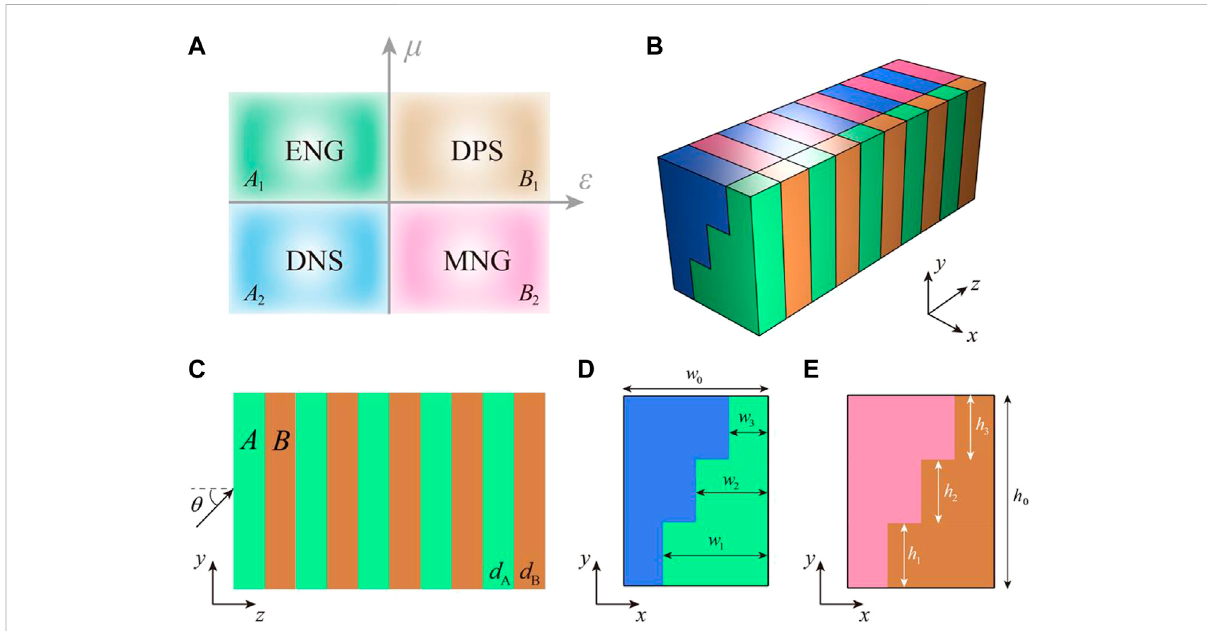
FIGURE 5 Step-like multilayer structure for MLCMM. (A) Electromagnetic parameter space of theisotropic media. DPS ( ε 1 > 0, µ 1 > 0), ENG ( ε 2 < 0, µ 2 > 0), DNS( ε 3 < 0,µ 3 < 0)andMNG( ε 4 > 0,µ 4 < 0) mediaaremarkedbybrown,green,blue,andpink, respectively. (B) Schematicofthestep-likemultilayer structure composed of four kinds of media in (A) . (C) The cross graph of multilayer structure in the plane of x-z . (D) The cross graph of composite layer A inthe plane of y-z . (E) The cross graph of composite layer B in theplane of y-z . All the geometric parameters are marked as d A (cid:1) d B (cid:1) 15 nm, The fi lling ratio of width and height for A1 (B1) in the composite layer A (B) is w i / w 0 (cid:1) 0 . 22 , 0 . 19 , 0 . 16 and h i / h 0 (cid:1) 0 . 44 , 0 . 19 , 0 . 37 ( i (cid:1) 1 , 2 , 3 )